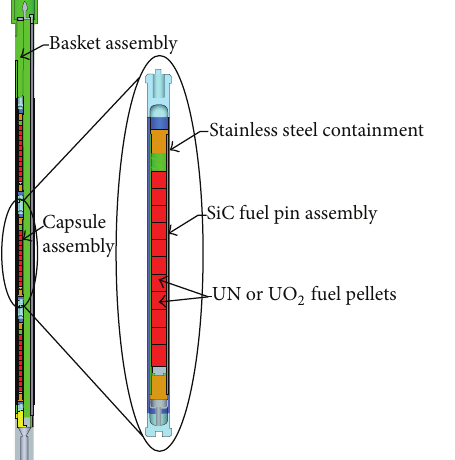
Table 2: Neutron fluxes for ATR ITV midplane specimens